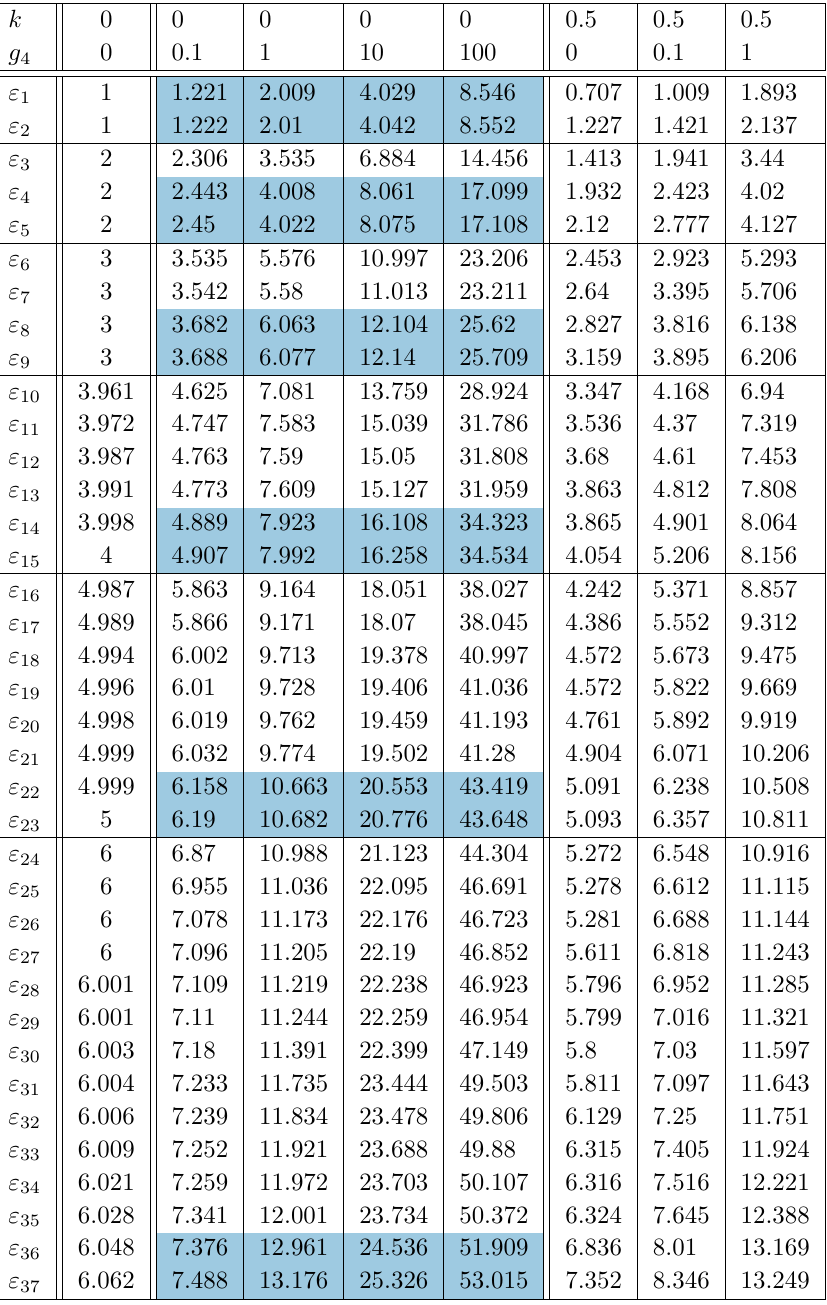
Table 15. Two-matrix spectrum with loop length truncation l = 6